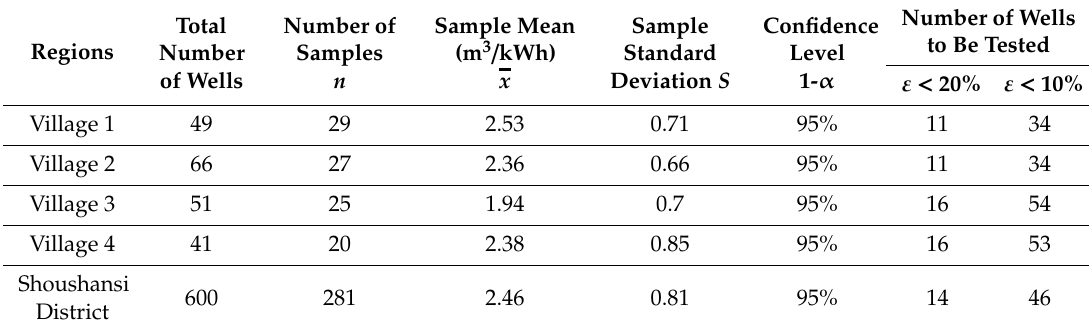
Table 2. Sample statistics and required sample